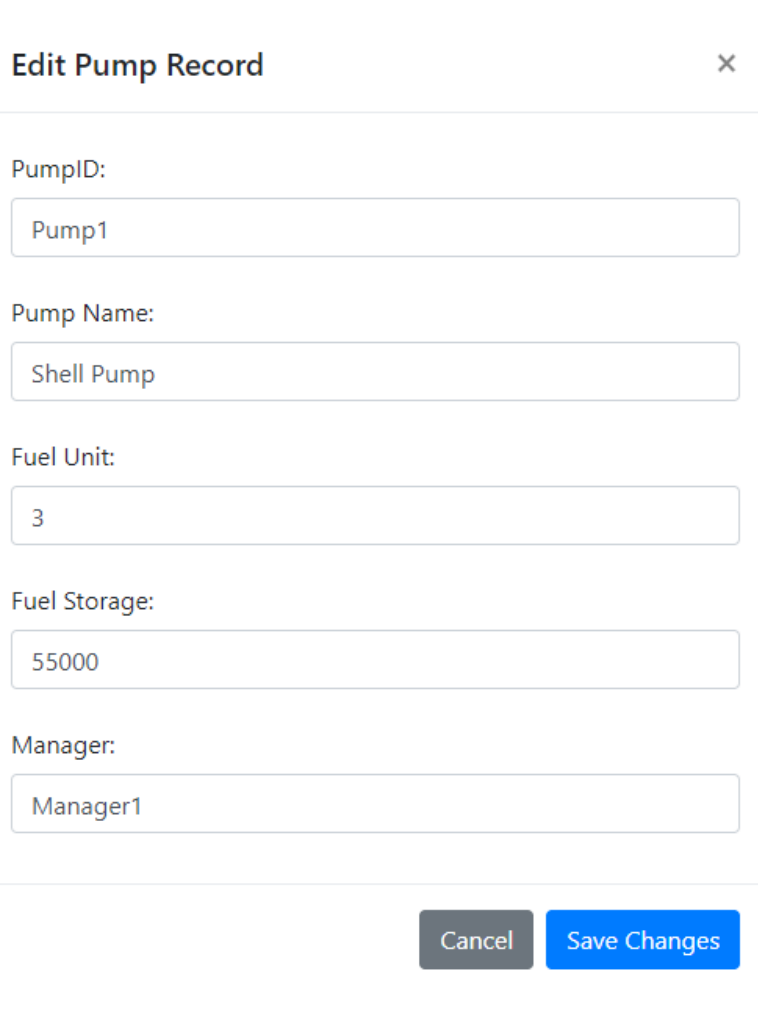
Figure 12. Pump management dashboard: update pump record.